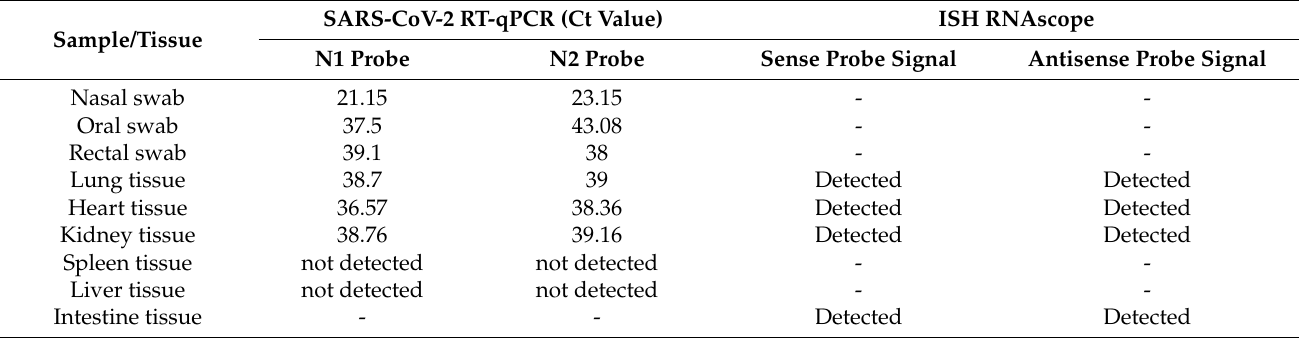
Table 1. Detection of SARS-CoV-2 by RT-qPCR and ISH RNAscope in swabs and tissue samples collected from a dog. SARS-CoV-2 RT-qPCR (Ct Value) ISH RNAscope Sample/Tissue N1 Probe N2 Probe Sense Probe Signal Antisense Probe